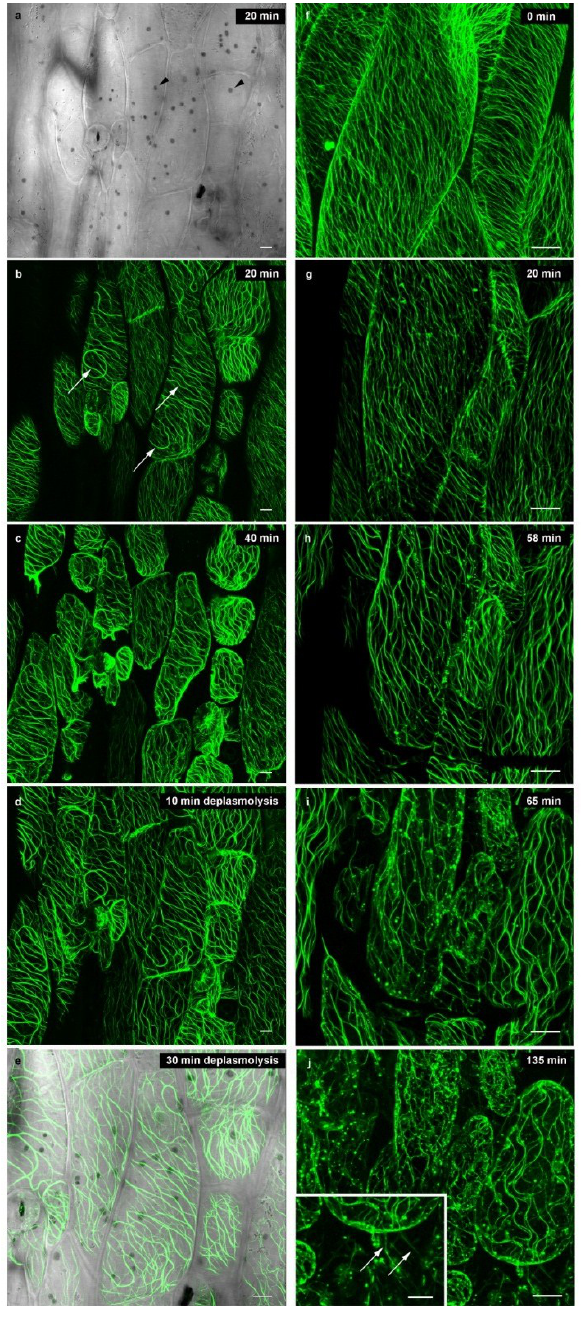
Figure 3. Cortical microtubules (GFP-MAP4) in Arabidopsis hypocotyl cells during plasmolysis ( a – c ; f – j ) and deplasmolysis ( d , e ); plasmolysis/deplasmolysis times marked on the micrographs. ( a ) Bright field image showing cell walls, occasional stomata and chloroplasts (arrowheads); ( b ) Bundling of microtubules (arrows) at the onset of plasmolysis in 0.8 M mannitol; ( c ) After 40 min, cortical microtubules are showing waves and bundles; they remain aligned within the cortical cytoplasm; ( d ) Bundles of microtubules persist in deplasmolysis when the protoplasts become realigned at the cell wall; ( e ) Overlay of fluorescence and bright field image at the end of the plasmolytic cycle; chloroplasts appear as dark grey dots; ( f – j ) Higher magnification of plasmolysing hypocotyl cells; inlay in ( j ) shows microtubules in Hechtian strands (arrows). Bar: 10